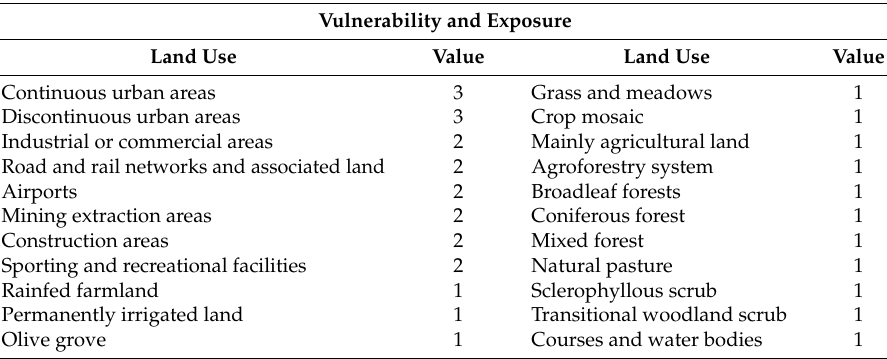
Table 3. Assigning values according to land